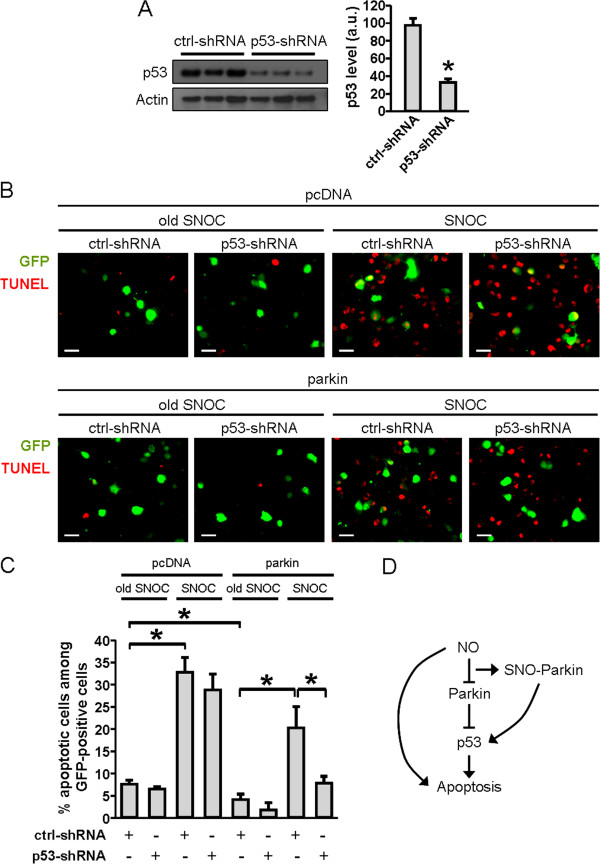
Role of p53 in NO-induced death in SH-SY5Y cells overexpressing parkin. A, Validation of p53-shRNA as a gene-silencing tool. SH-SY5Y cells were transfected with control (ctrl)- or p53 shRNA encoding plasmids, and the cell lysates subjected to western blotting using anti-p53 or actin antibodies. The optical density of the p53 bands was quantified and normalized to actin, n = 3; * p < 0.01. B, Histological images of SH-SY5Y cells transiently transfected with pcDNA or parkin plasmid. Cells were co-transfected with ctrl- or p53-shRNA plasmids that also encoded GFP (green). Cells were exposed to 600 μM old or fresh SNOC 24 h prior to TUNEL (red) staining. Scale bar: 20 μm. C, Percentage of TUNEL-positive cells among GFP-positive cells under the designated conditions. Values are mean + SEM of 41–83 cells per condition performed in triplicate experiments; * p < 0.05. D, Schematic representation of the pathway linking NO to apoptosis in this system.